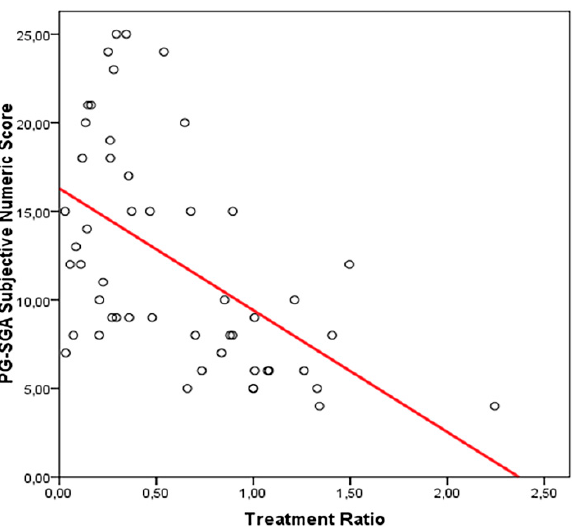
Figure 1. Linear correlation between PG-SGA subjective numeric score and TE-OPF intake.